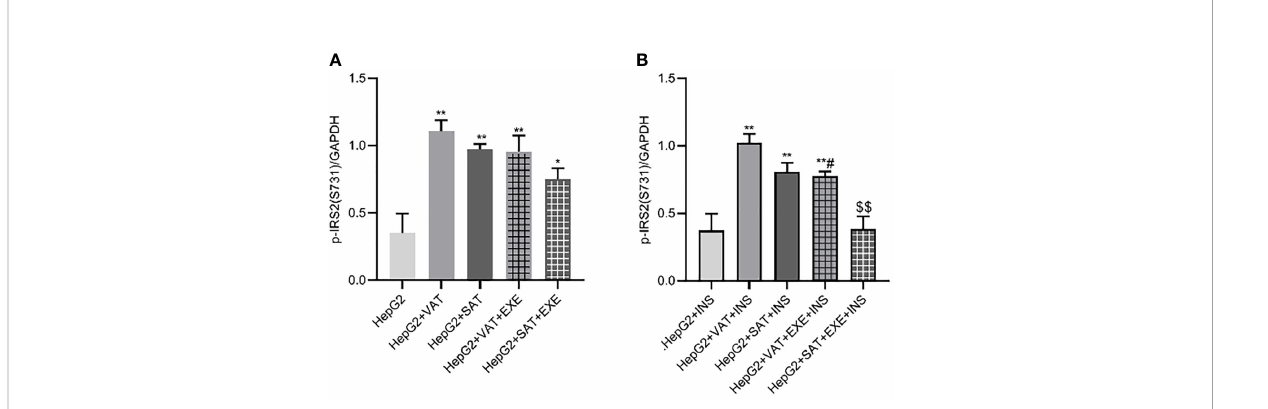
FIGURE 6 The in fl uence of exenatide on the expression of p-IRS2(S731) protein in hepatocytes conducted by different regional adipose tissue. (A) Expression of p-IRS2(S731) protein in HepG2 cells of each group. Data are means ± SEM, n = 3/group, *P < 0.05, **P < 0.01 vs. HepG2 group. (B) Expression of p-IRS2(S731) protein in HepG2 cells of each group under the action of insulin. Data are means ± SEM, n = 3/group, **P < 0.01 vs. HepG2+INS group; # P < 0.05 vs. HepG2+VAT+INS group; $$ P < 0.01 vs. HepG2+SAT+INS